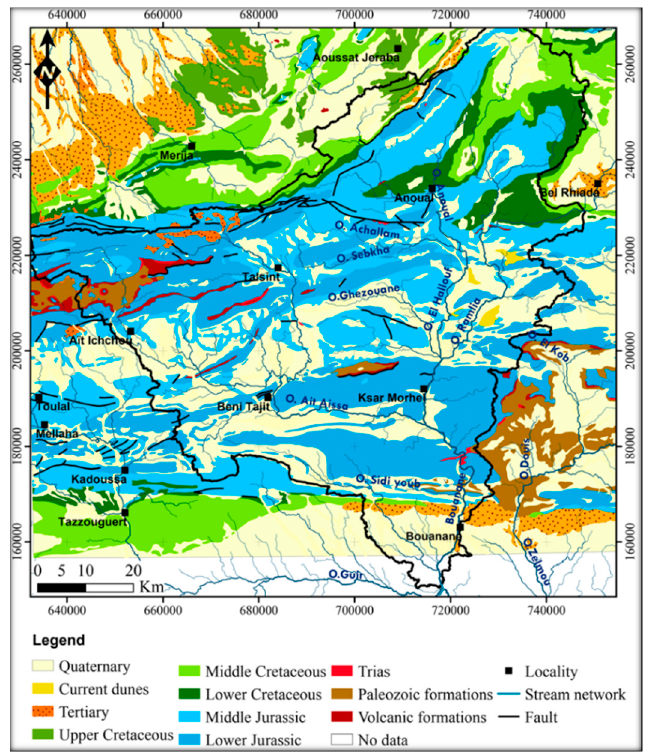
Figure 3. Geology of High Atlas in the study area (modified from [21]). Note that there is an unmapped strip in the south because the available geological maps do not cover the entire study area.